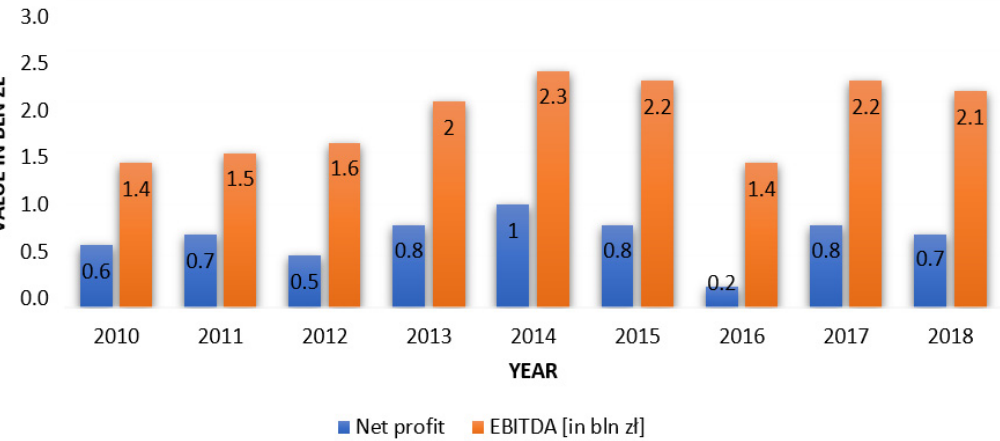
Figure 4. Financial results of the Energa group from 2010–2018. Source: author’s study based on https://wysokienapiecie.pl/24792-orlen-chce-przejac-energe/ (access date: 15 August 2021).